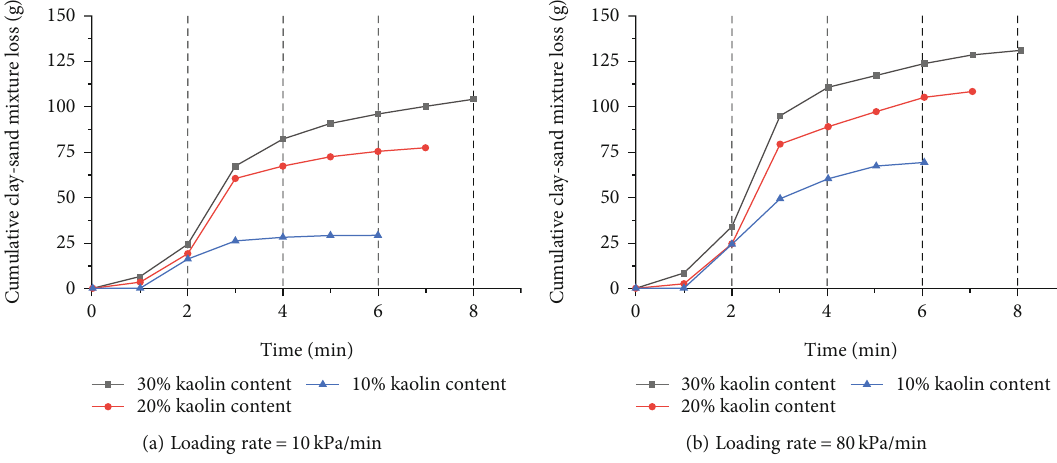
Figure 6: Variation curves of cumulative sandy-clay mixture loss for di ff erent kaolin contents.